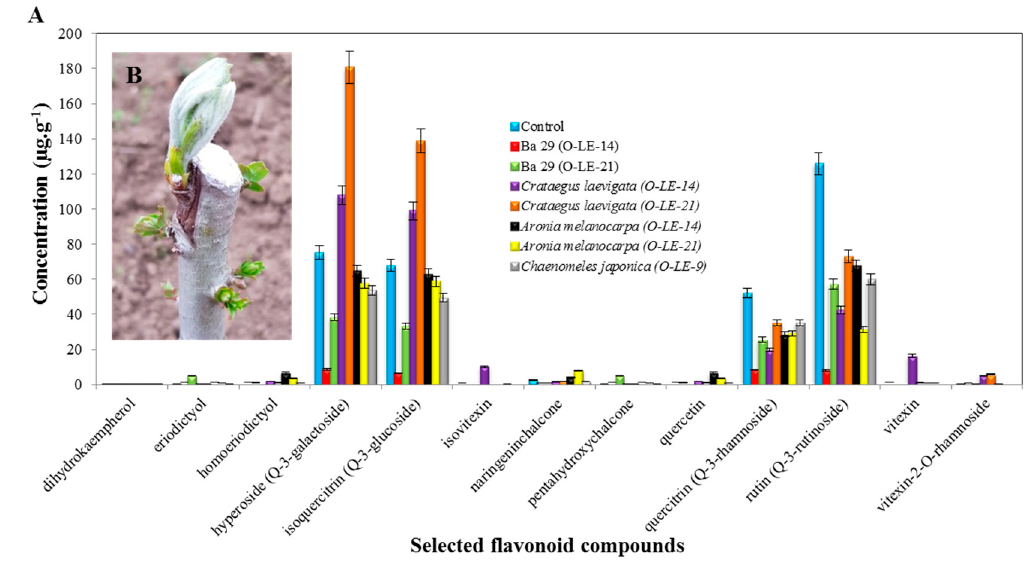
Figure 1. ( A ) Determination of the concentration of selected flavonoid compounds in the extract from the rootstocks of plants; ( B ) demonstration of the cleavage site.